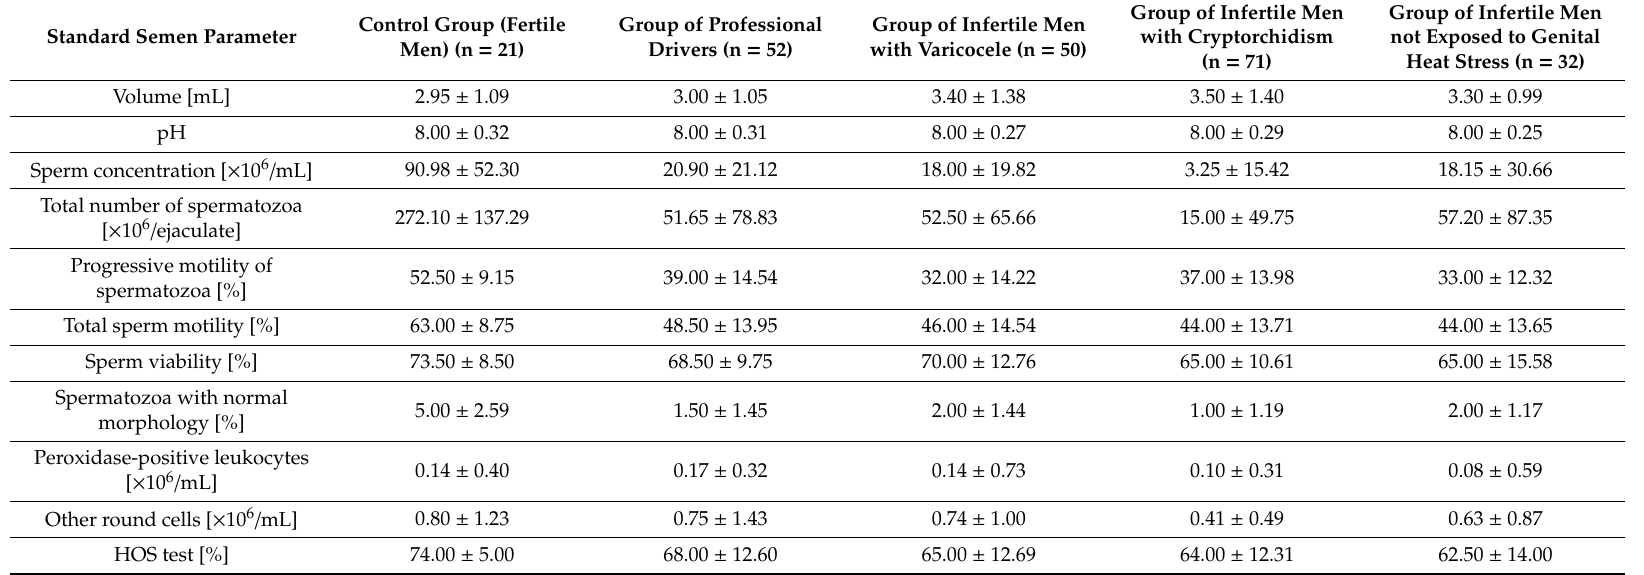
Table 3. Spermiogram parameters in the studied